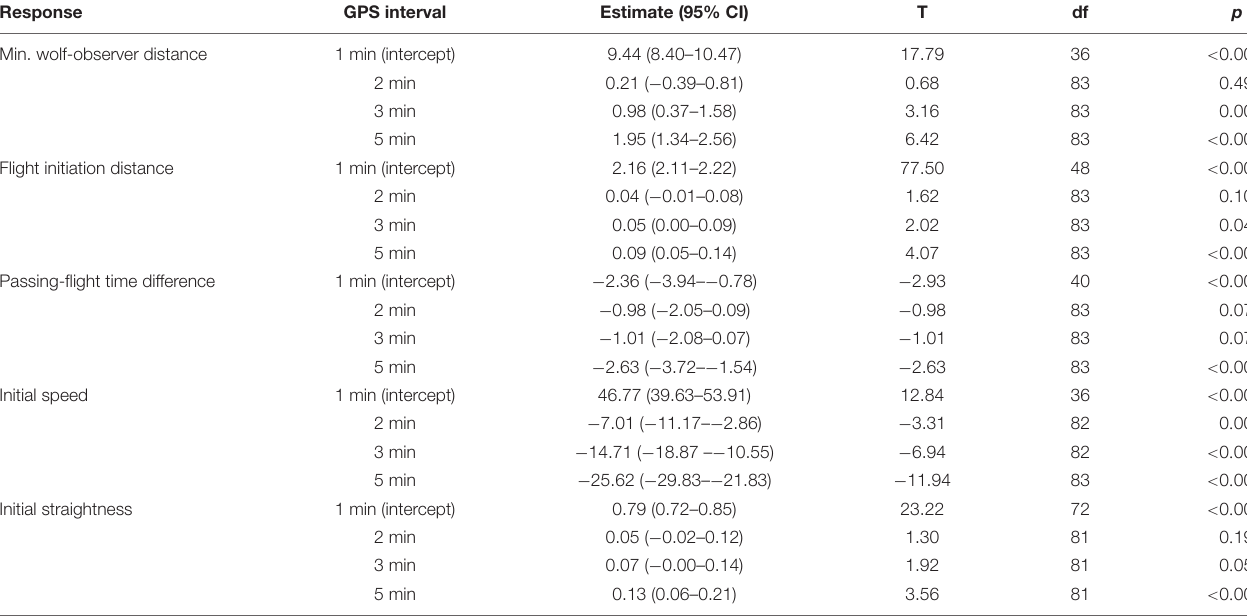
TABLE 4 | Generalized linear mixed models (GLMMs) comparing initial wolf flight responses calculated from GPS data at varying sampling intervals during experimental human approach trials on wild wolves (first 10 min after flight initiation).